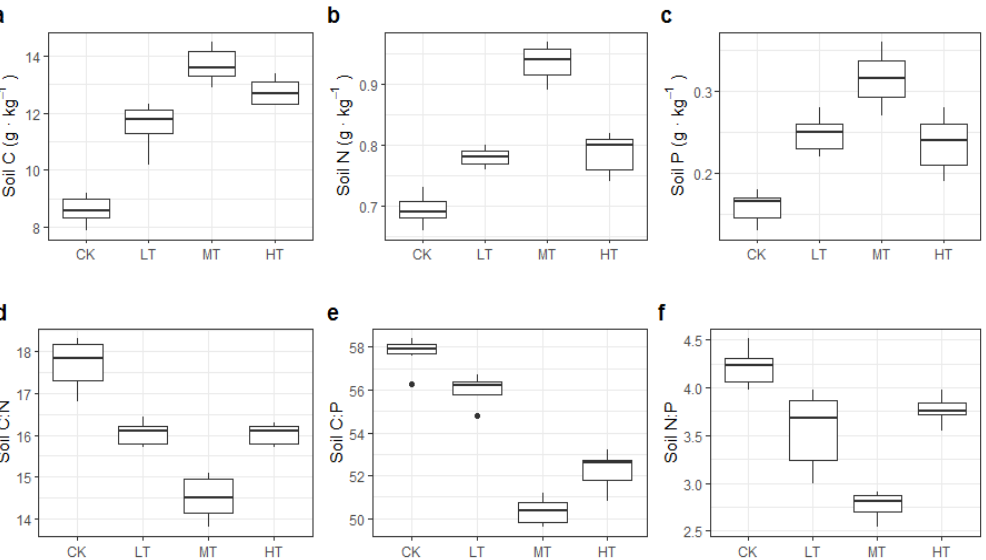
Figure 1. Changes in the soil C, N, and P content ( a – c ) and soil C:N, C:P, and N:P ratios ( d – f ) among four thinning treatments. CK: control (0% thinning); LT: light (50%) thinning; MT: moderate (63%) thinning; HT: heavy (80%) thinning. Same below.